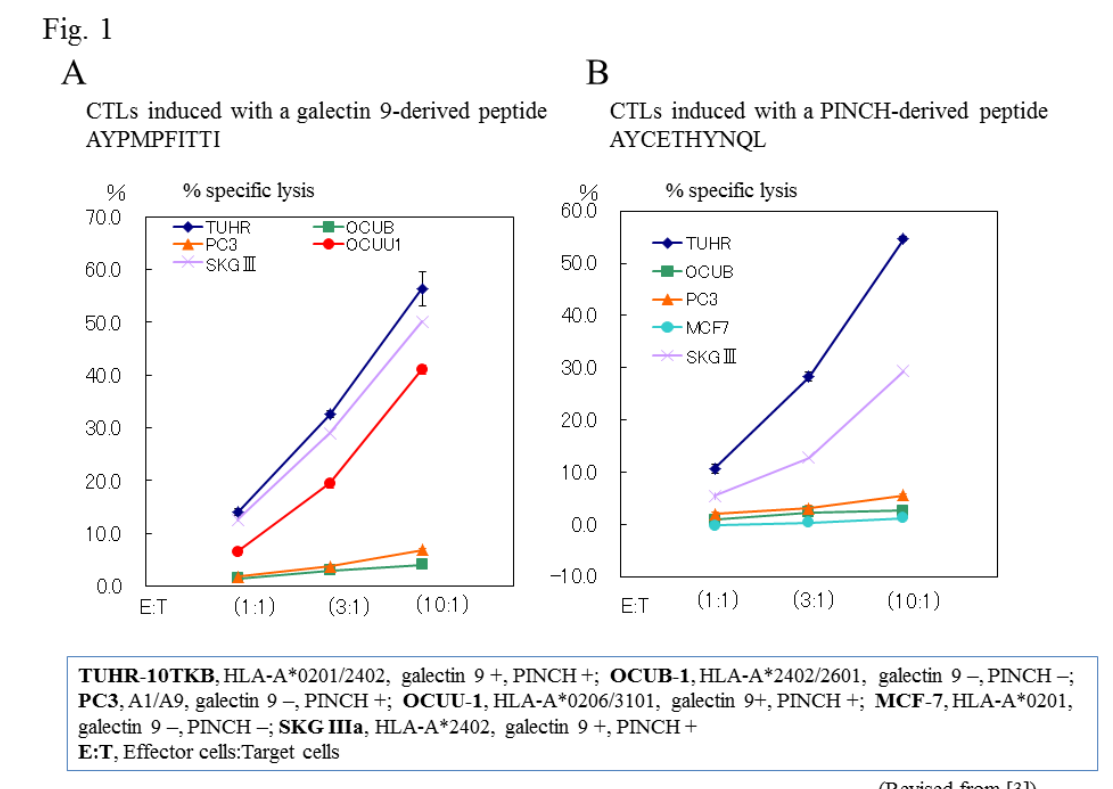
Figure 1. Antigen-specific, HLA-A*2402-restricted cytotoxicities of CTLs induced with galectin 9- derived (A) and PINCH-derived peptides (B). A, B. Peripheral blood mononuclear cells from healthy volunteers (HLA-A*2402) were stimulated with galectin 9-derived and PINCH-derived peptides, respectively, to induce CTLs. The cytotoxicity of the CTLs toward RCC cells was assessed by a 51Cr- release assay (21).CTLs induced by both peptides showed high cytotoxic activity toward TUHR-10TKB RCC cells (HLA-A*2402+, galectin 9+, PINCH+) and SKGIIIa uterine cancer cells (HLA-A*2402+, galectin 9+, PINCH+). CTLs were not active toward cells with different HLA-A or negative antigens. Bars represent means±standard errors of assays performed in triplicate. A. CTLs induced by the galectin 9-derived peptide exhibited cytotoxicity toward OCUU-1 RCC cells (HLA-A*0206+, galectin 9+), implying less stringency in terms of HLA-A for the CTLs